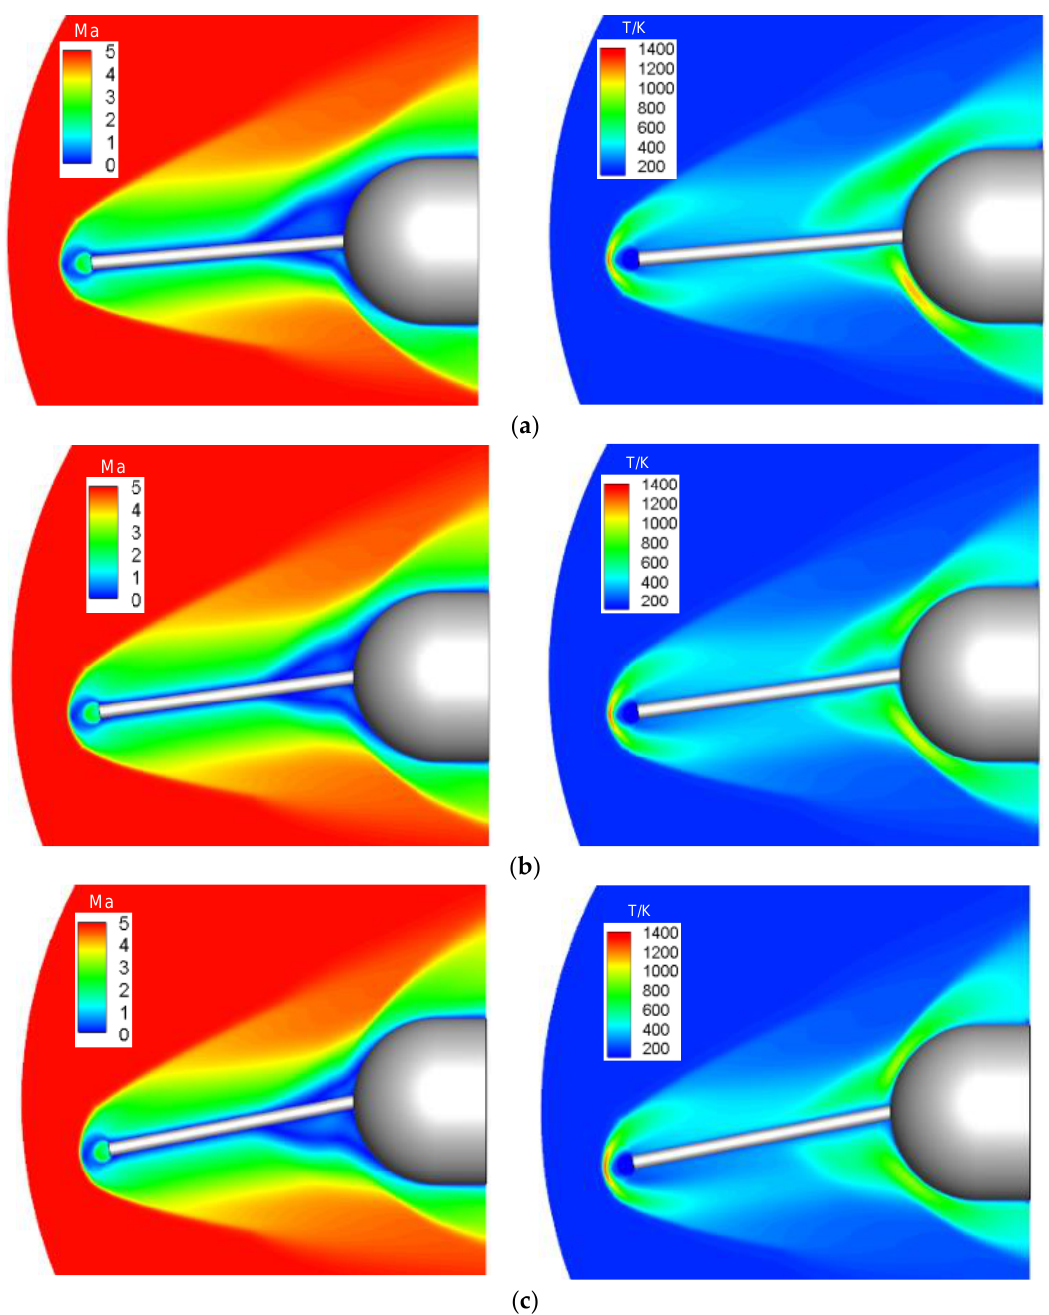
Figure 9. Flow field at different installation angles: ( a ) η = 5°; ( b ) η = 8°; ( c ) η = 11°. The heat flux distribution of the nose cone at different installation angles is shown in Figure 10, the peak heat flux and corresponding position are shown in Figure 11. With the angle η increasing from 5° to 12°, the peak heat flux of the windward side decreases from 53.75 kW/m 2 to 22.88 kW/m 2 , a decrease of 57.43%. Meanwhile, the peak heat flux of the leeward side increases from 9.65 kW/m 2 to 37.03 kW/m 2 , an increase of 283.73%. According to Figure 11a, the optimal installation angle and corresponding peak heat flux are 10.42° and 28.95 kW/m 2 , respectively. In addition, increasing the angle η causes the peak heat fluxes of leeward and windward sides to move forward and backward, respectively. As the angle η increases from 5° to 12°, θ max of the windward side is increased by 47.95%, while θ max of the leeward side is reduced by 39.32%.